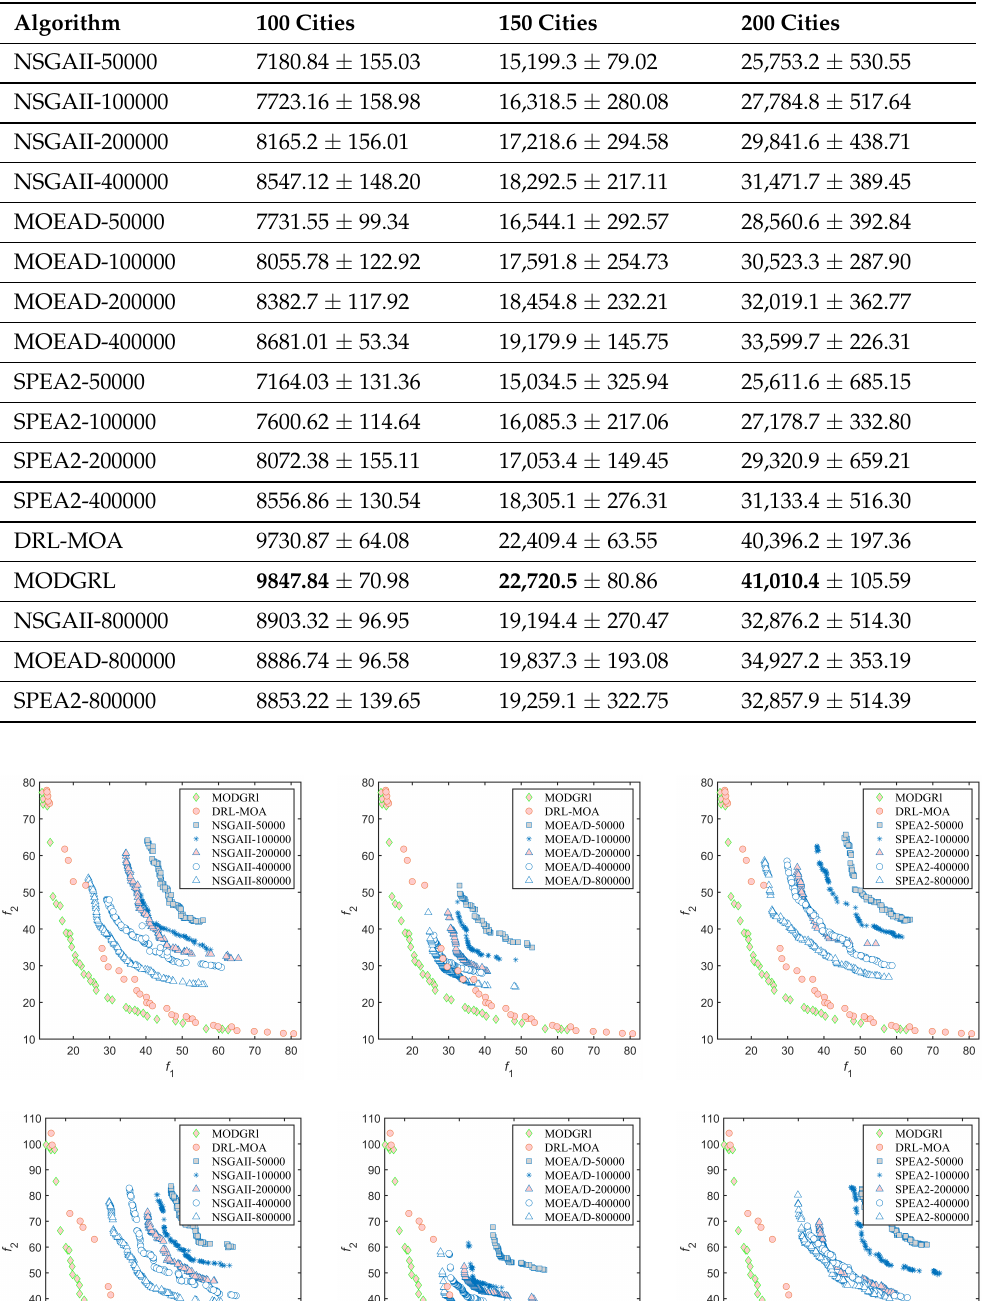
Table A1. Comparison of hypervolume values. The maximum values is the best. The bold values are the best ones among all algorithms.